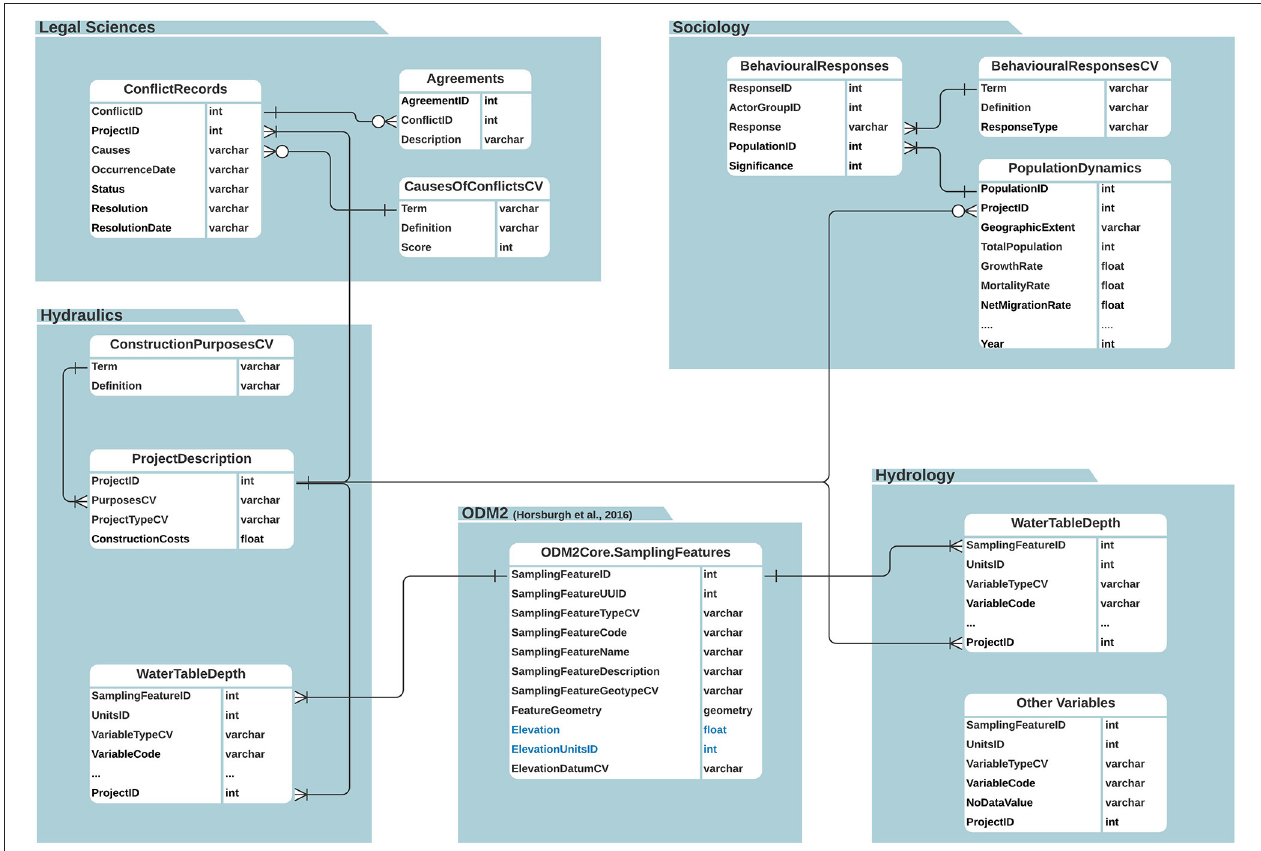
FIGURE 2 | Example of data model schema conceptualized based off the agricultural hydroinformatics framework and the ODM2 developed by Horsburgh et al. (2016). It depicts four components of the proposed framework with related table definitions that may be used in developing a data model. The identifier field for each tuple (row) in the tables ends with the string “ID” with or without the +–